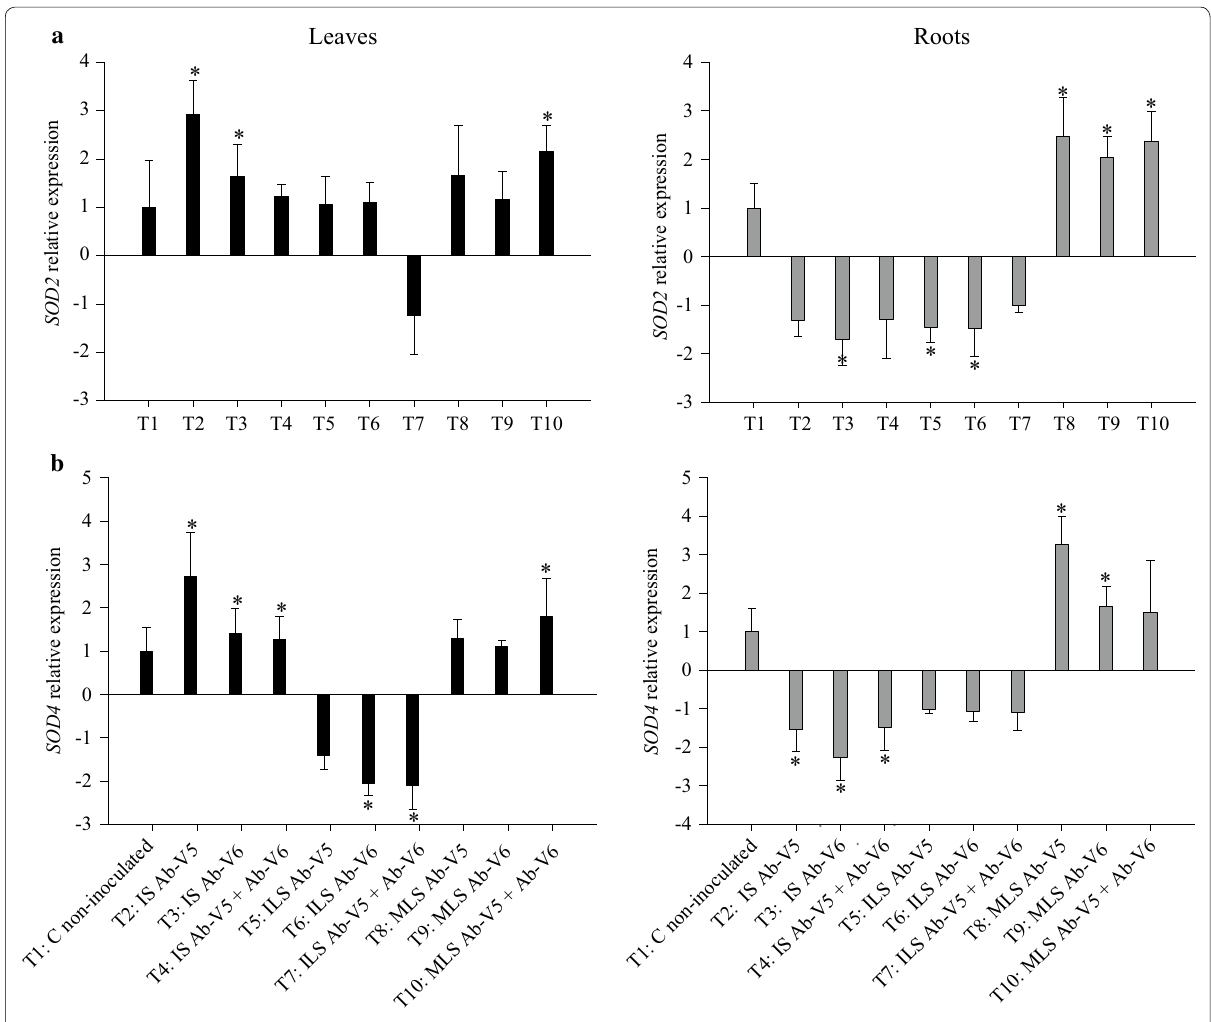
Fig. 2 RT-qPCR analysis of the expression of a SOD2 and b SOD4 genes, as described in the legend of Fig.